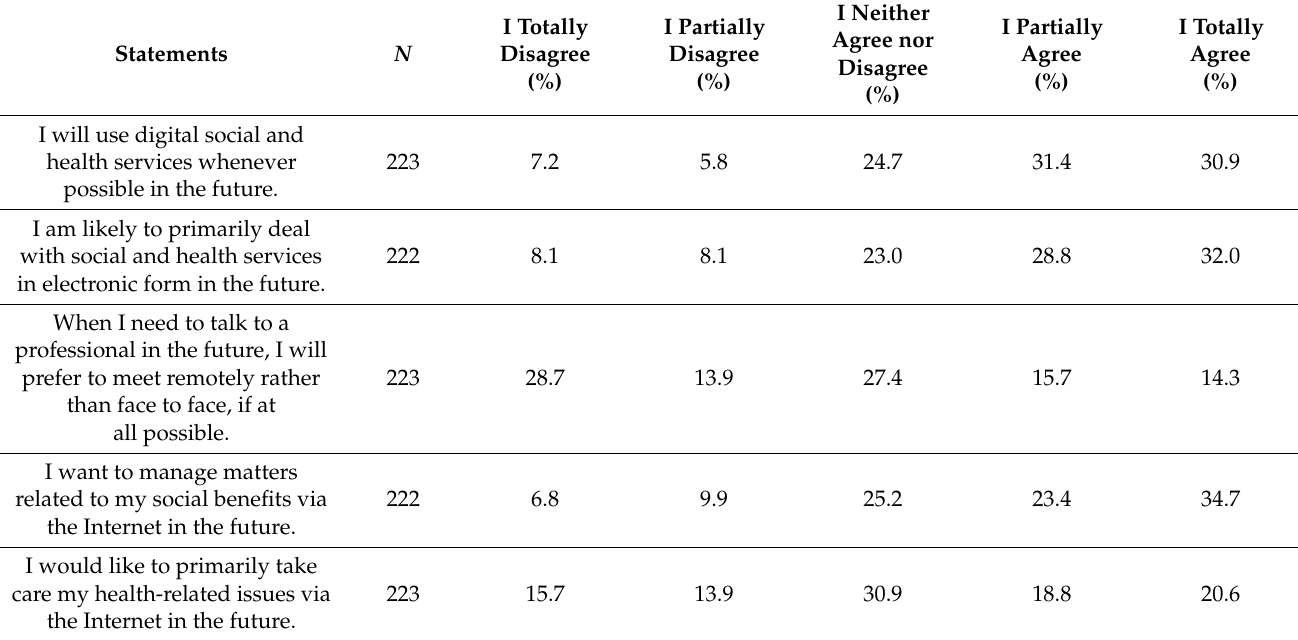
Table 2. The distributions of the responses regarding behavioural